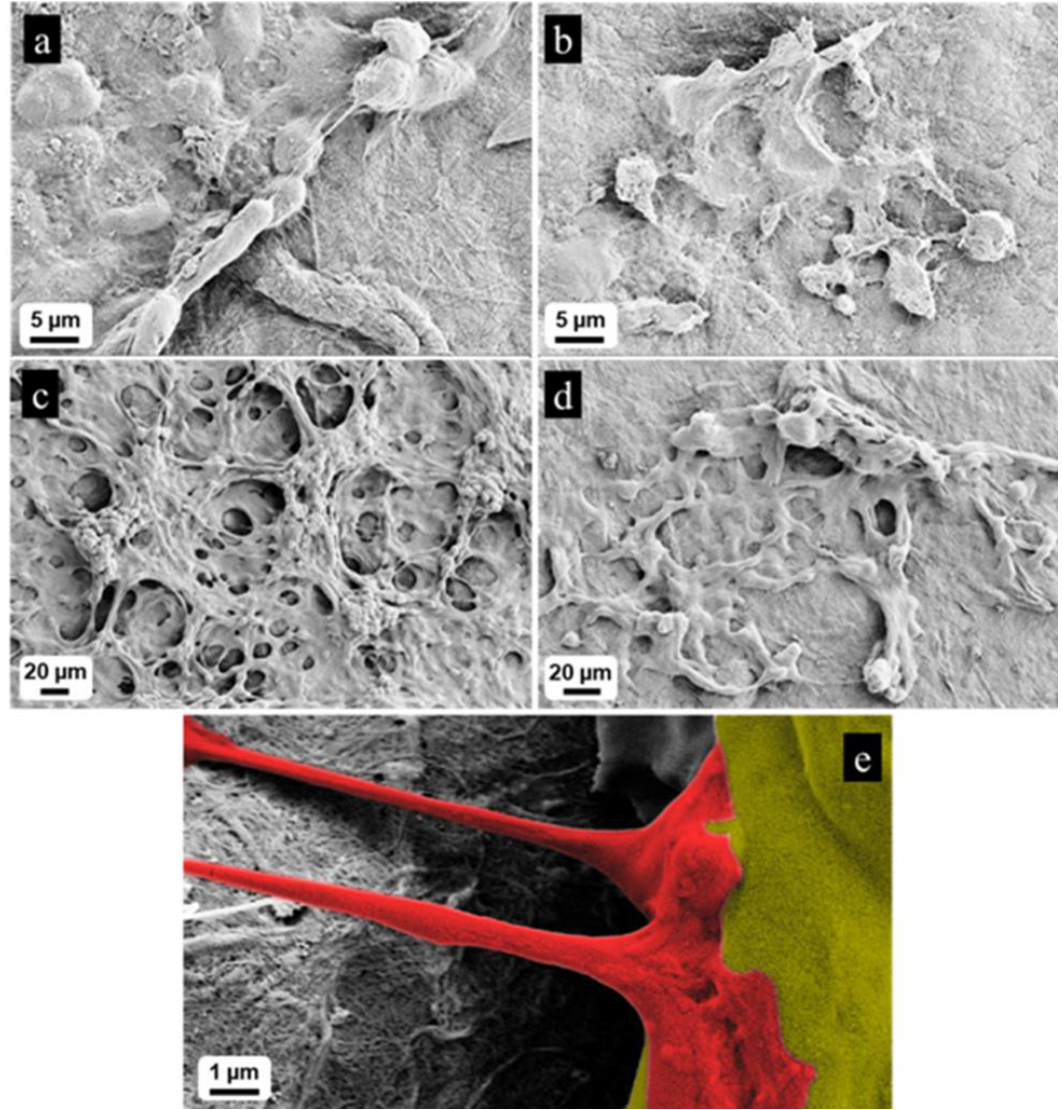
Figure 4. ( a ) Cells cultivated on pure NFC scaffold in presence of differentiation factors started to differentiate in 10 days, but they seem to not generate a neural network. Scale bar: 5 µm. ( b ) Cells cultivated on pure NFC scaffold without differentiation factors did not differentiate. Scale bar: 5 µm. ( c ) Cells cultivated on NFC/10% CNTs with differentiation factors highly differentiated and generated a very complex neural network, with many connections between neurons. Scale bar: 20 µm. ( d ) Cells cultivated on NFC/10% CNTs without differentiation factors differentiated and generated a small neural network. Scale bar: 20 µm. ( e ) Example of synapse found in the sample of cells cultivated in conductive scaffold without differentiation factors. Scale bar: 1 µm.